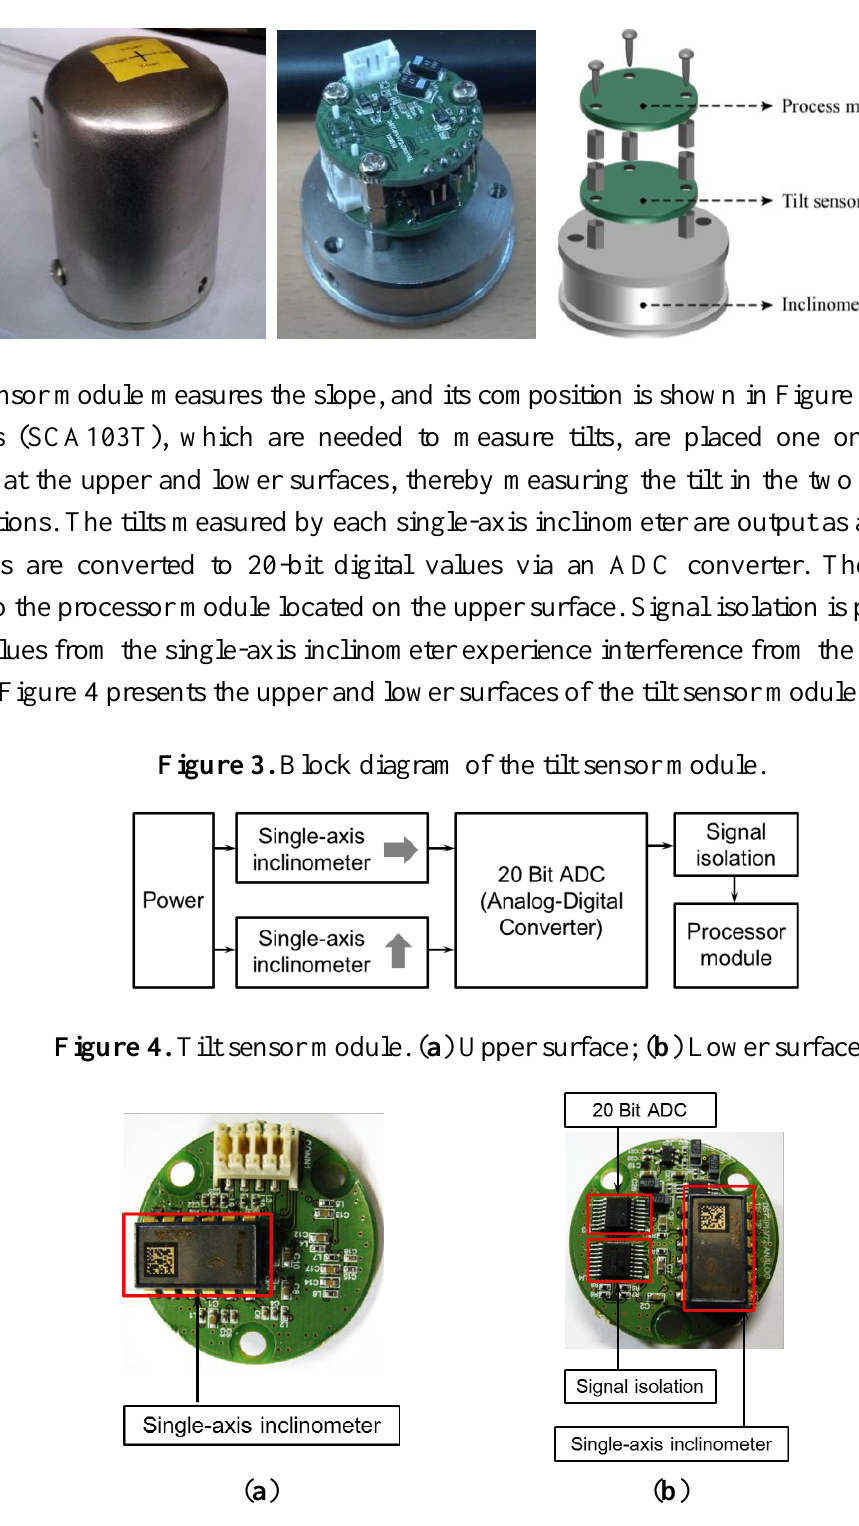
Figure 2. MEMS-based inclinometer.